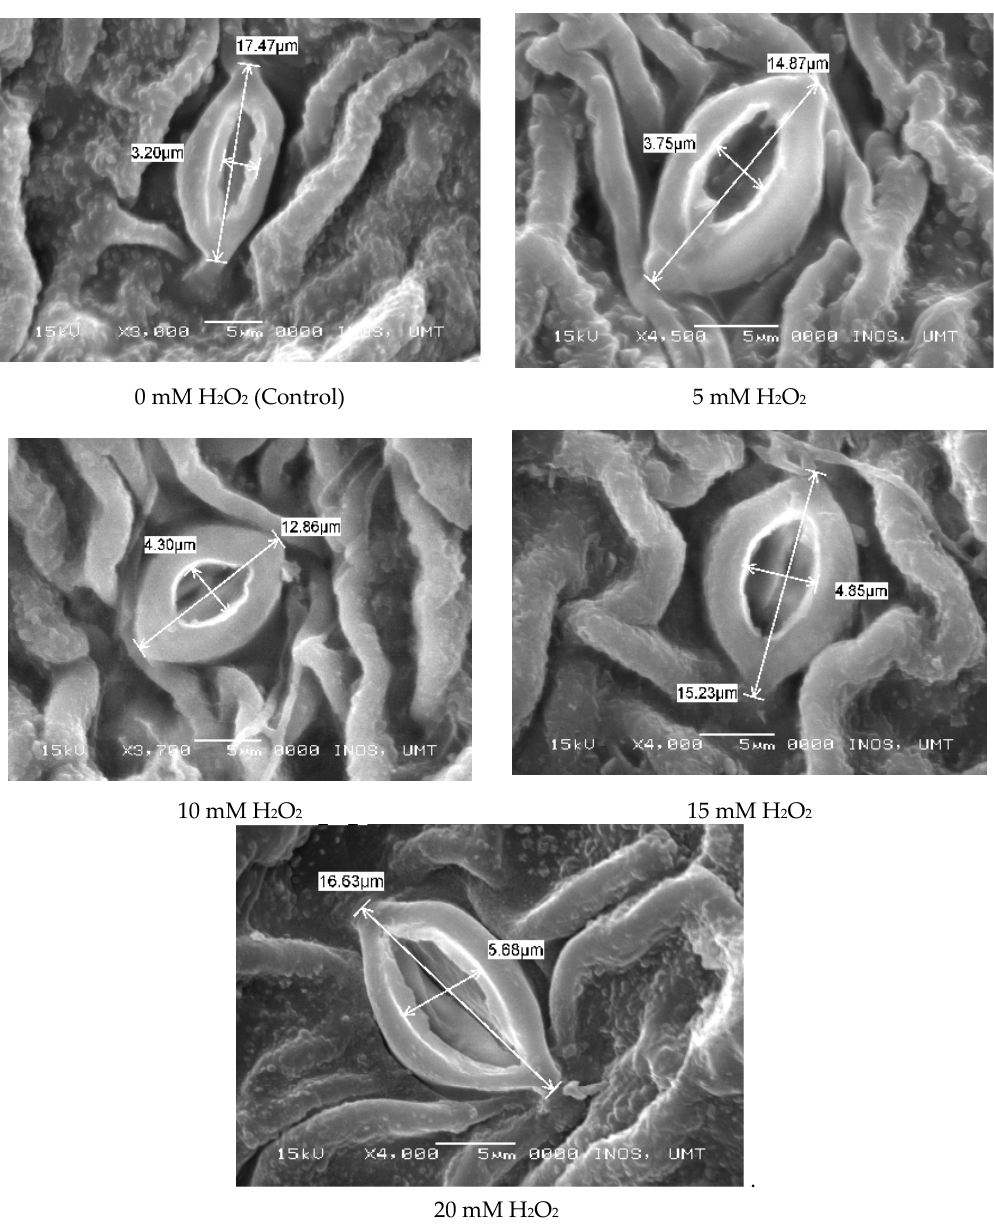
Figure 1. Scanning Electron Microscopy (SEM) photographs show single stomatal size of the H 2 O 2 -treated and untreated leaf of Ficus deltoidea var. deltoidea